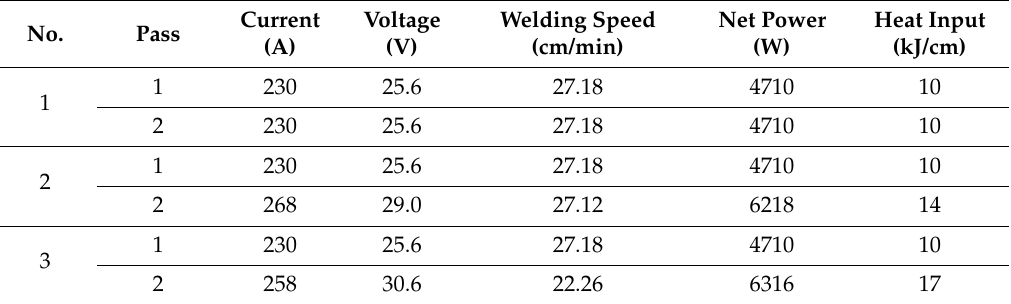
Table 2. Mechanical properties of the steels and welding wire.